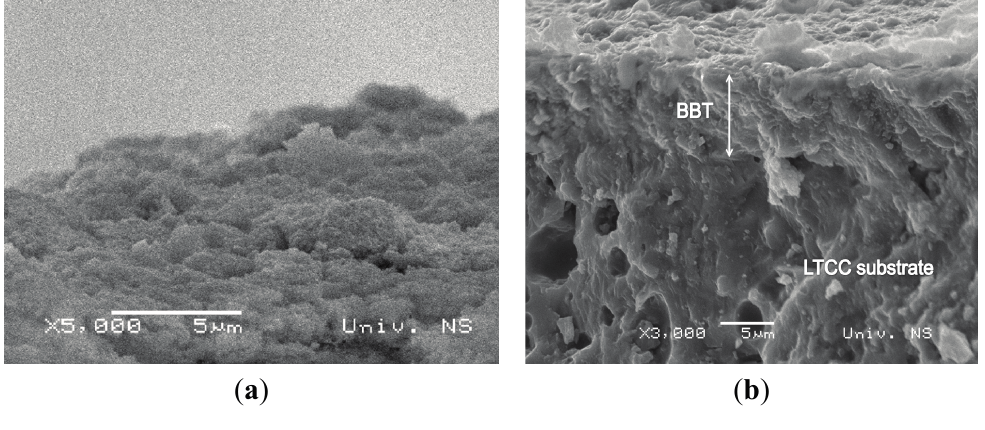
Figure 10. SEM micrographs of the BBT film: ( a ) 550 °C; ( b ) 800 °C, cross